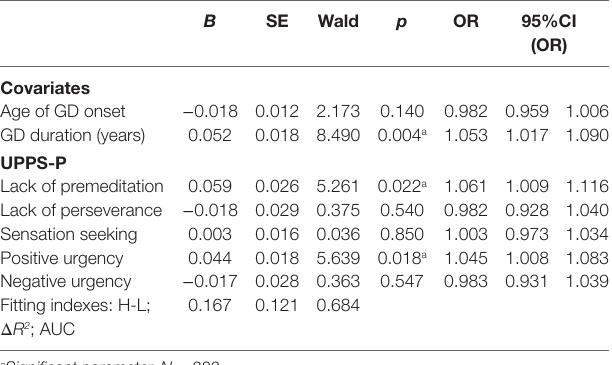
a Significant parameter. N = 382. H-L, Hosmer–Lemeshow test (p-value); Δ R 2 , increase in the Nagelkerke’s R 2 coefficient comparing blocks 1 and 2; AUC, area under the ROC curve.